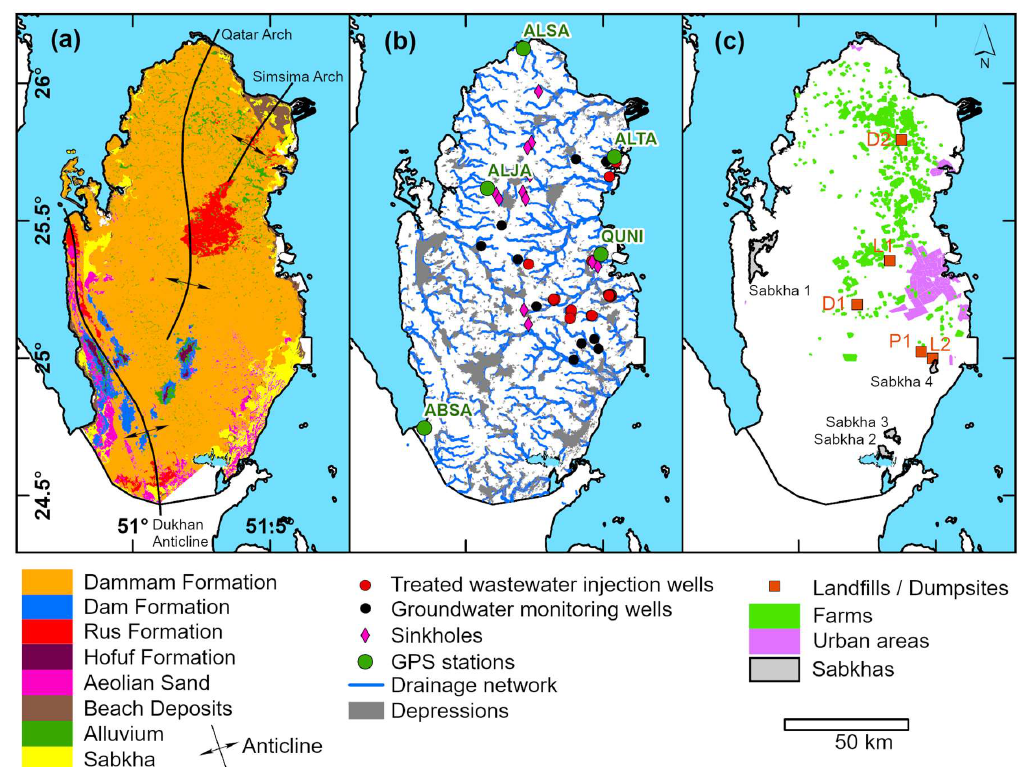
Figure 1. Geological, hydrological, and land-use/land-cover (LULC) maps of Qatar. ( a ) Simplified geological map showing the distribution of geological units and major structural elements (modified after [35]). ( b ) Distribution of drainage networks and depressions extracted from 30 m ALOS World 3D DEM downloaded from data dissemination service https://www.eorc.jaxa.jp/ALOS/en/aw3d30/ (accessed on 19 February 2020) provided by Japan Aerospace Exploration Agency (JAXA). Likewise shown are the locations of treated water injection wells, groundwater monitoring wells, sinkholes, and GPS stations (provided by MME). ( c ) LULC data layers (i.e., farms, urban areas), locations of dump sites (D1: Rawdat Rashed; D2: Umm Thanyatain), landfills (L1: Umm Al Afai; L2: Mesaieed), and solid waste processing plant (P1: Domestic Solid Waste Management Center) and investigated inland sabkhas (Dukhan: sabkha 1) and coastal sabkhas (Mamlaha: sabkha 2; Afjat Wadi Abu Al Ghurban: sabkha 3; Afjat Saadoon: sabkha 4).